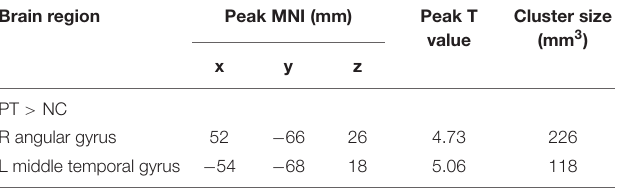
TABLE 2 | Brain regions with significant group differences in CBF/ReHo ratio.